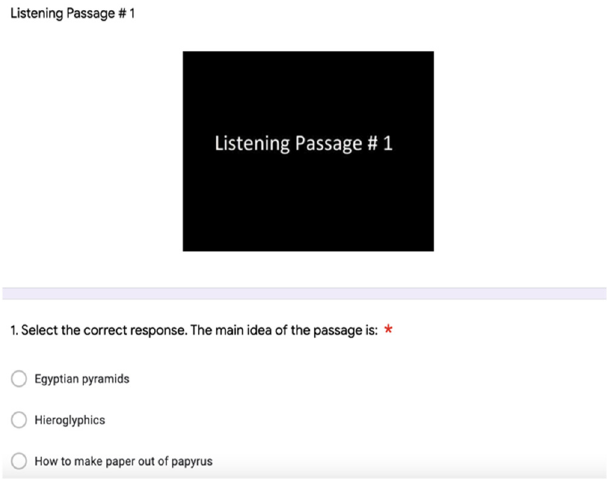
Figure 5. Assessment example. Note: * indicates that a test-taker’s response is required.